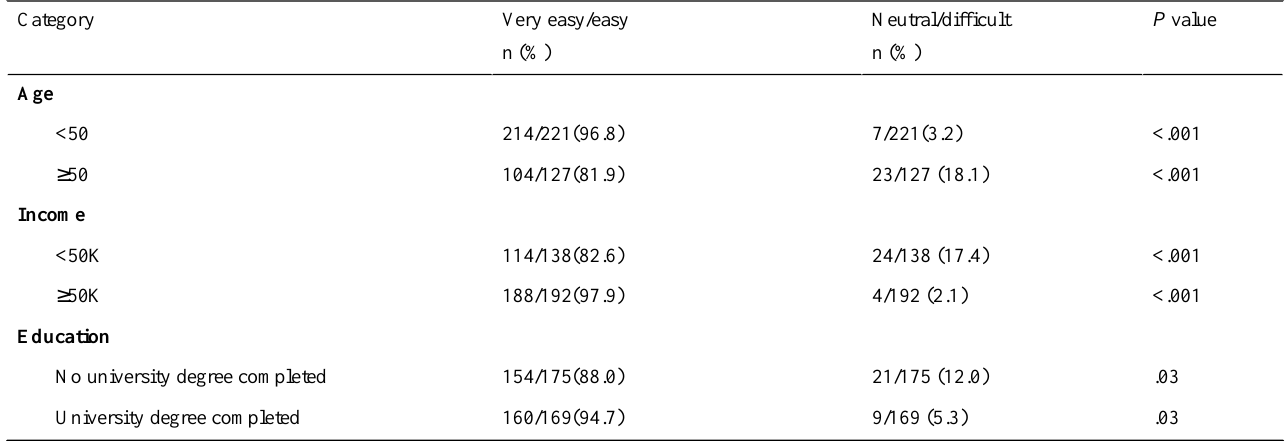
Table 2. Ease of use rating by patients.